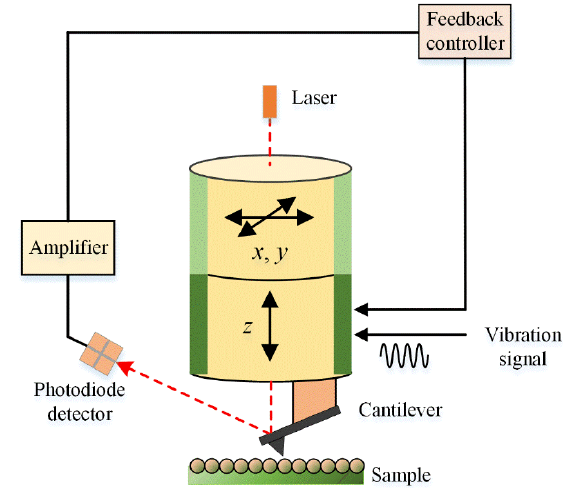
Fig. 1 Schematic of vibrational excited FFM. A sine voltage signal generated by an additional signal generator was added to the scanning ceramic tube in FFM